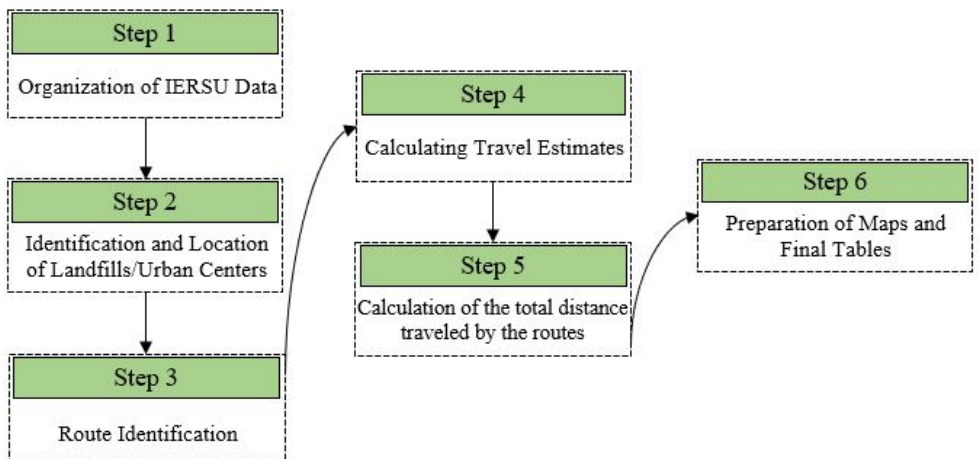
Figure 2. Methodology flowchart containing the research steps.